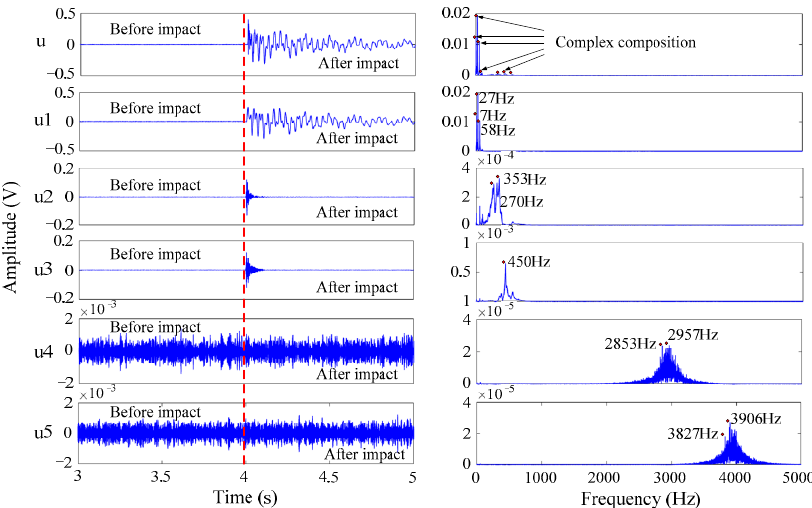
Figure 7. Results of the variational mode decomposition (VMD) of FBG2.